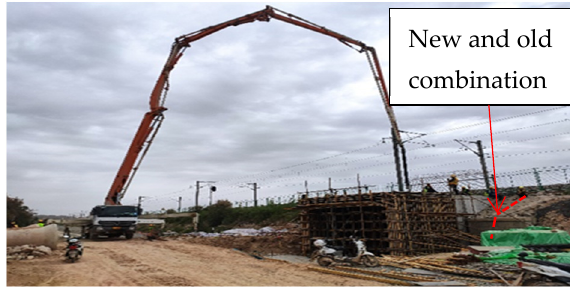
Figure 8. Concrete pouring construction